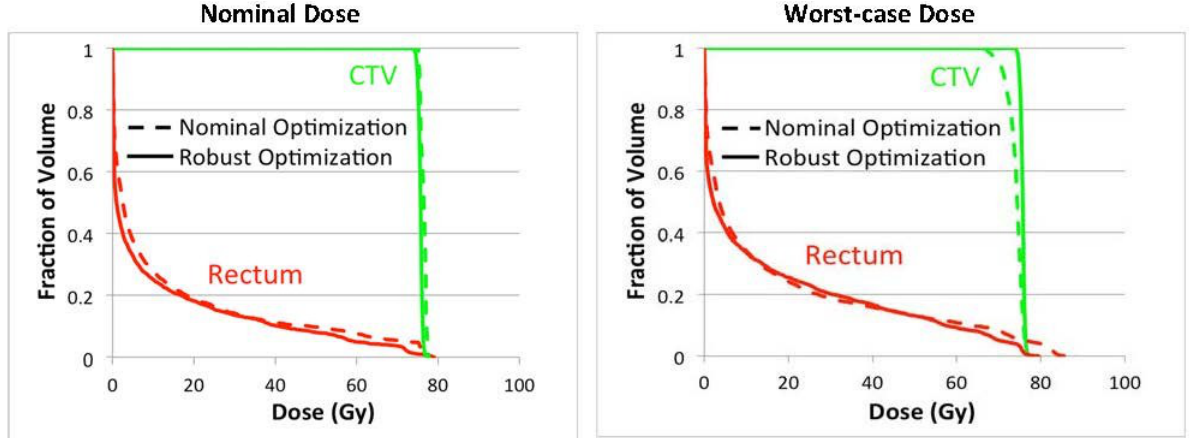
Figure 4. Dose (RBE) volume histograms for CTV and rectum from nominal and worst-case dose distributions based on nominally and robustly optimized plans with three beams (0°, 150°, 270°) for one prostate cancer patient.